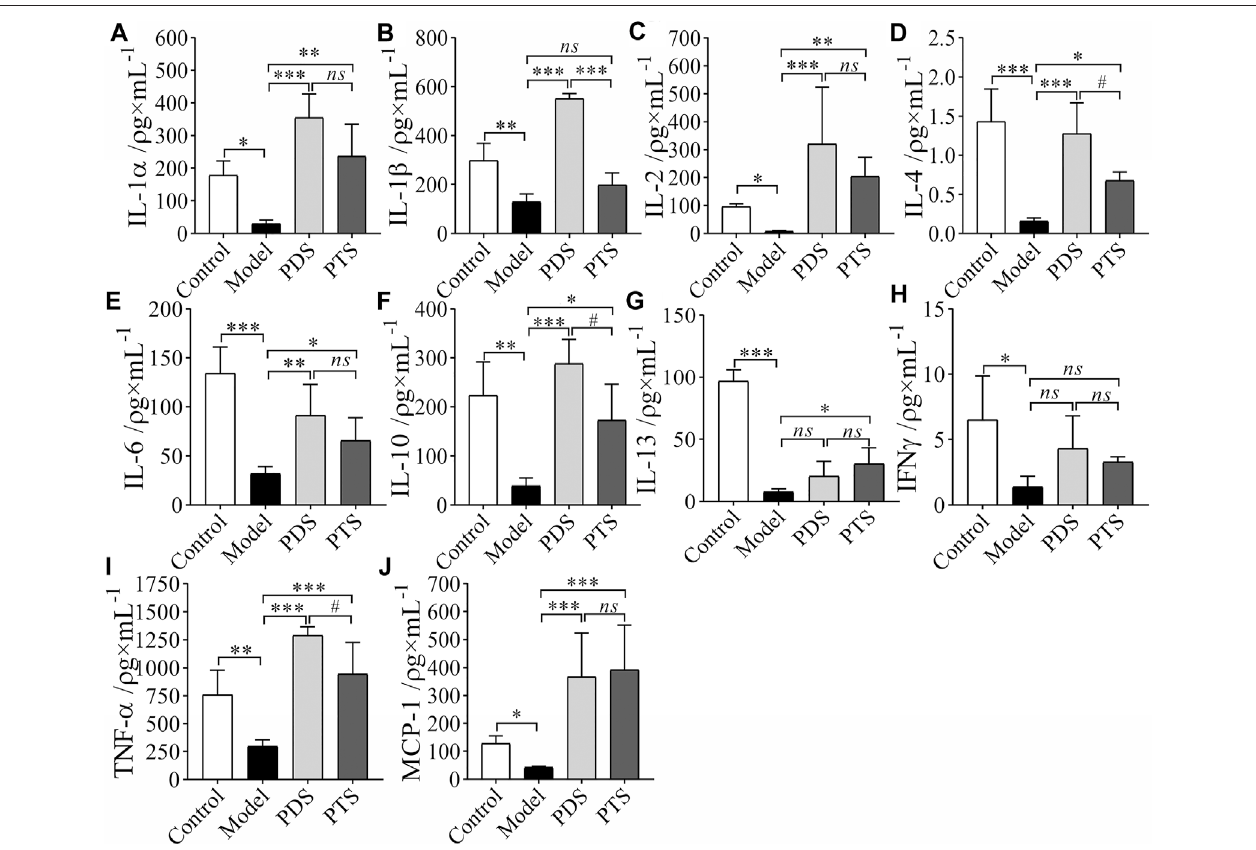
FIGURE 6 | The effects of PDS and PTS on the levels of in fl ammatory cytokines in myelosuppression mice by using biotin-label-based antibody arrays. (A) IL-1 α ; (B) IL-1 β ; (C) , IL-2; (D) , IL-4; (E) , IL-6; (F) , IL-10; (G) , IL-13; (H) , IFN γ ; (I) , TNF- α ; (J) , MCP-1. The data are expressed as mean ± SD ( n ≥ 4), * p < 0.05, ** p < 0.01, and *** p < 0.001 compared with the model group; # p < 0.05 compared with PTS group, ns showed no signi fi cance between the two